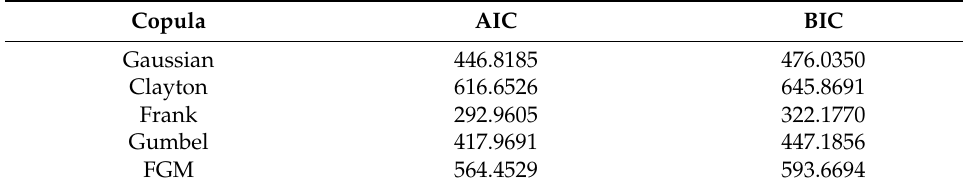
Table 7. The AIC and BIC values for different copula